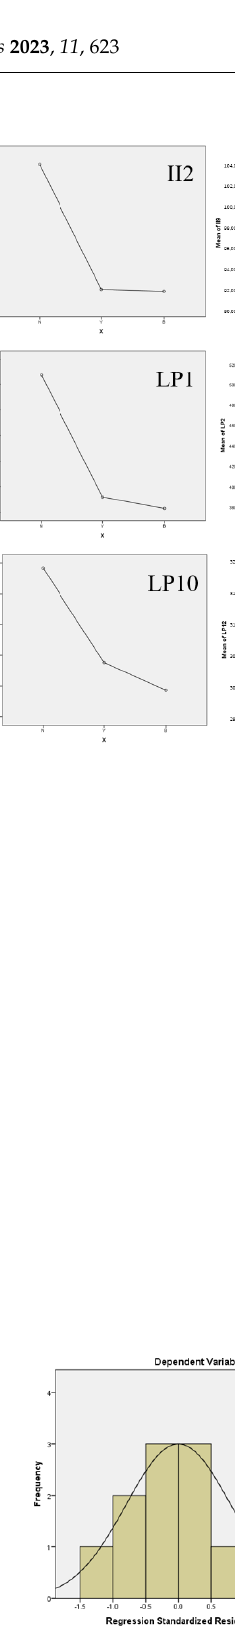
Figure 8. Mean Plots (Positive growth).